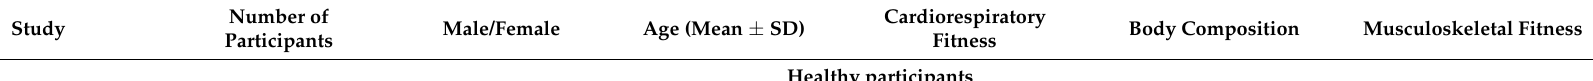
Table 2. Narrative description of the intragroup changes after the